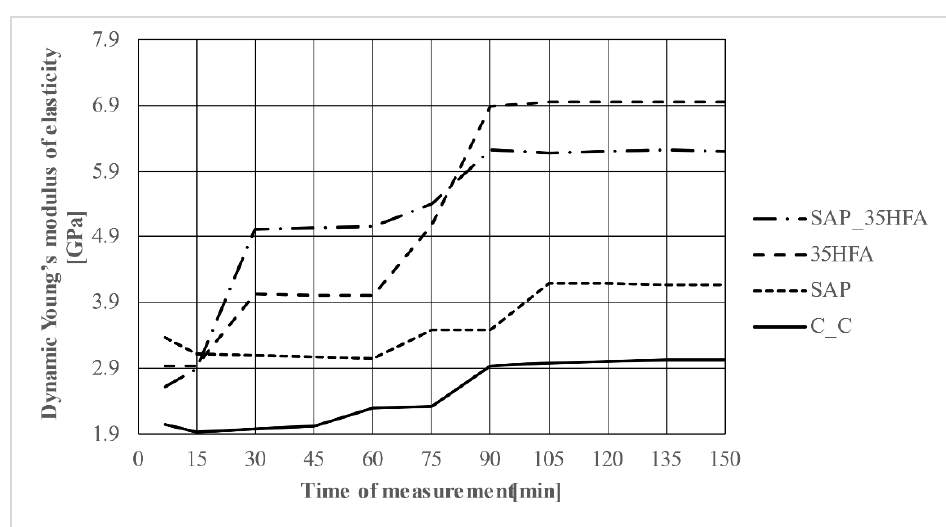
Figure 13. Dynamic Young’s modulus of elasticity over time.